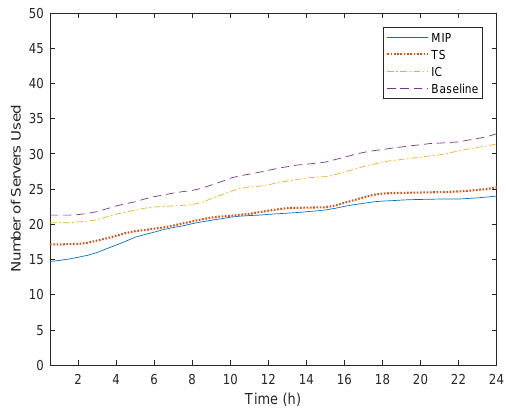
Figure 10. Total number of nodes used.